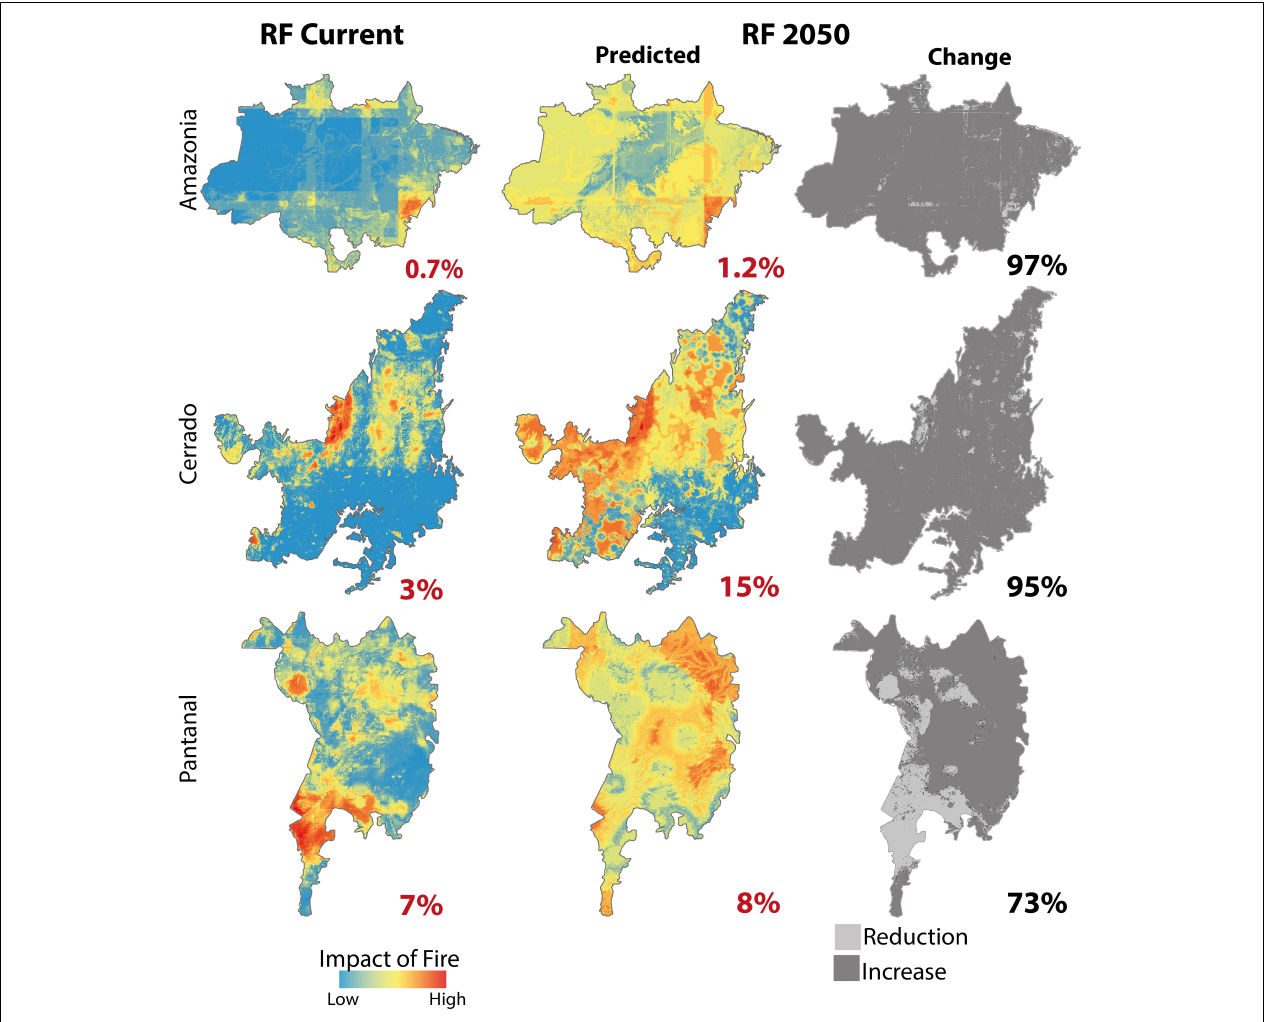
FIGURE 3 | Fire impact from the Random Forest (RF) model for the present, left column and in middle column forecast by 2050 for the RCP4.5-MIROC5 and strong environmental governance. Figures in the third column depict the change in the impact of fire under this scenario. The numbers in red indicate the percentage of the biome with HIF today and in the future, and the numbers in black the percentage of biome that would have an increase in the impact of fire.